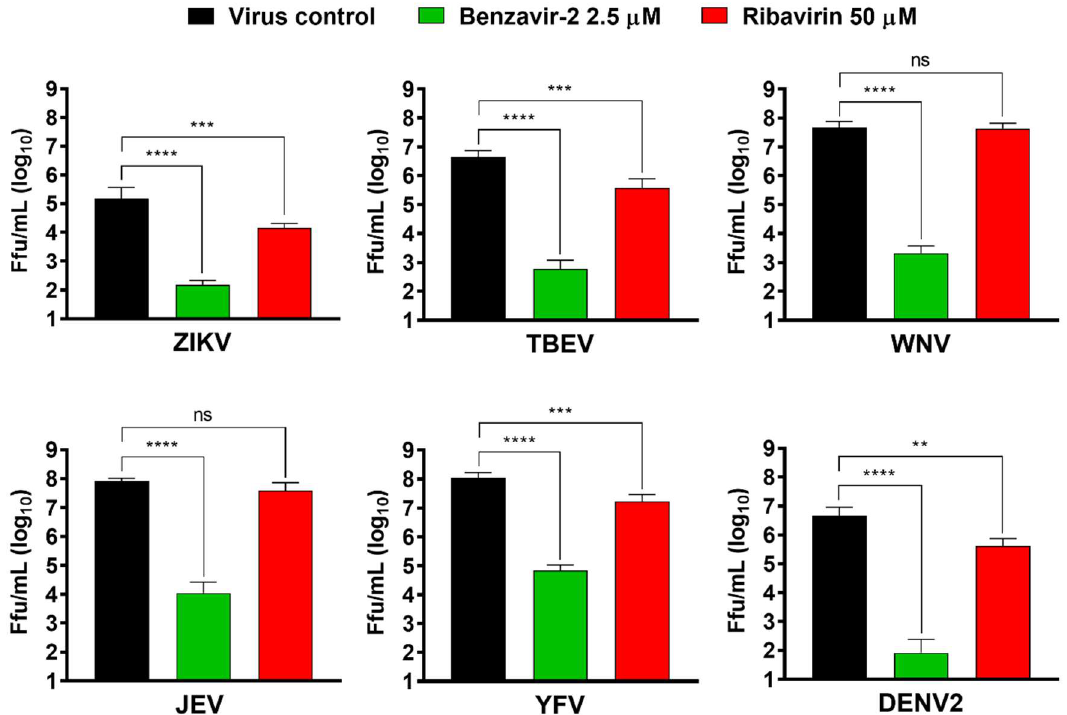
Figure 6. Benzavir-2 inhibition of flavivirus infection analyzed with a focus-forming assay. Monolayers of Vero B4 cells were infected with Zika virus (ZIKV), tick-borne encephalitis virus (TBEV), West Nile fever virus (WNV), Japanese encephalitis virus (JEV), yellow fever virus (YFV), or dengue virus type 2 (DENV2) with a multiplicity of infection (MOI) of 0.1 in the presence of benzavir-2 (2.5 µ M), ribavirin (50 µ M), or DMSO in the virus control. After 1 h, virus inoculum was removed, the cells were washed, and media containing the compounds or DMSO was added. Supernatants were harvested at 24 h post-infection (hpi) (TBEV and ZIKV) or 48 hpi (WNV, JEV, YFV, and DENV2), and virus titers were measured by focus-forming assay. Mean values and standard deviations from two independent experiments performed in triplicates are shown. The statistical significance was determined by one-way ANOVA, followed by Dunnett’s multiple-comparisons test. ** p < 0.01, *** p < 0.001, **** p < 0.0001; not significant (ns).